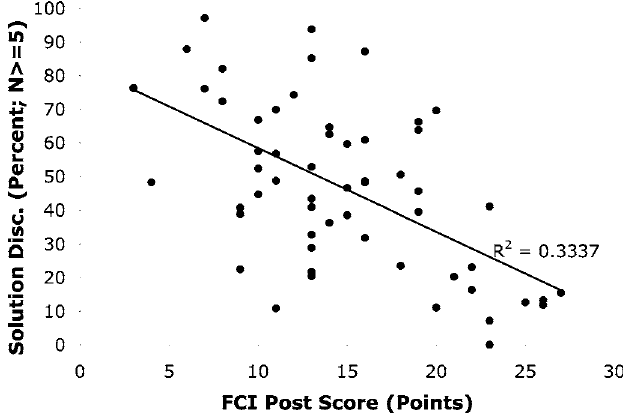
FIG. 4. Correlation of percentage solution-oriented discussions with final FCI score ( R =−0.58 (cid:3) −0.73 → −0.38 (cid:4) (cid:1) n =57 (cid:2) )